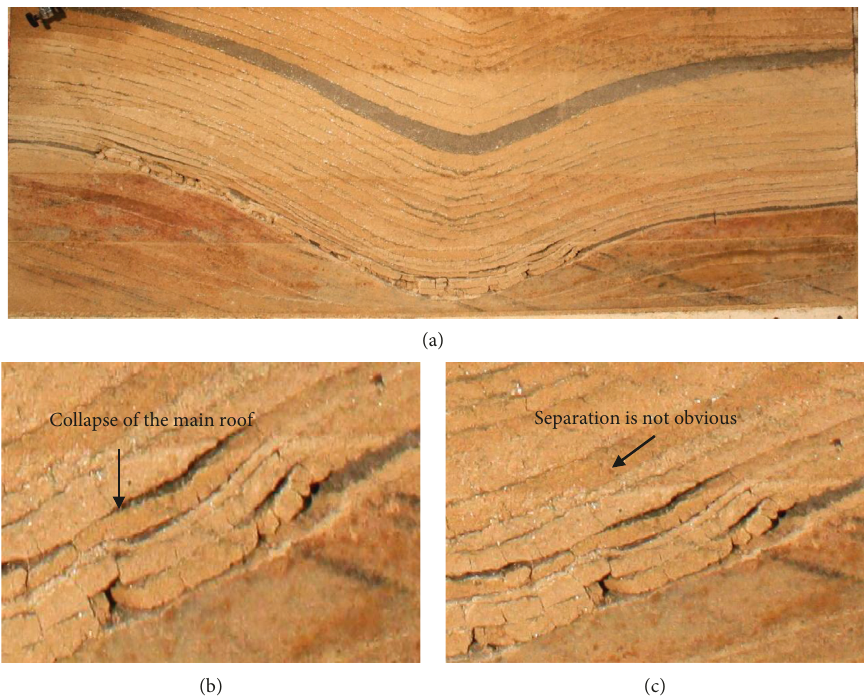
Figure 9: Periodic pressure of the main roof in the downhill mining section. (a) The whole picture of the model after the breakage caving of the main roof. (b) Collapse of the main roof. (c) The state of the overlying